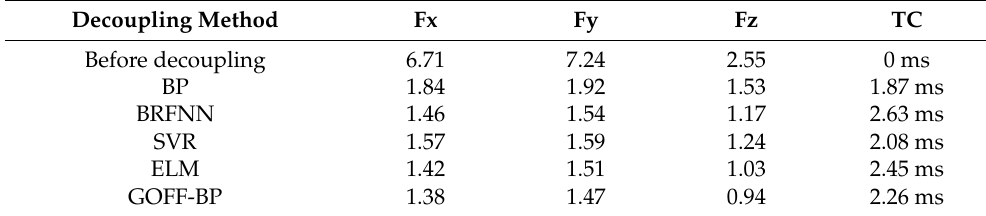
Table 2. Comparison of maximum type II errors of decoupling